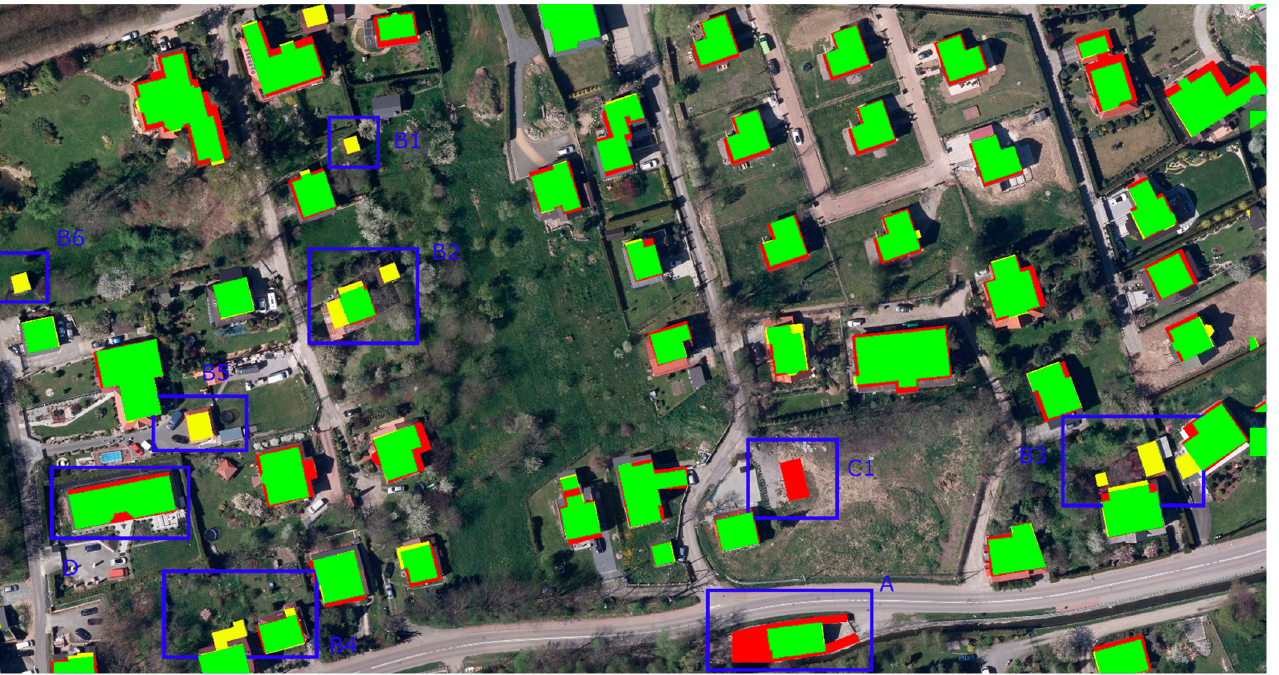
Figure 1. Comparison of data from EGIB and OSM (green—common parts of both databases, yellow—objects only in EGiB database, red—objects only in OSM database).